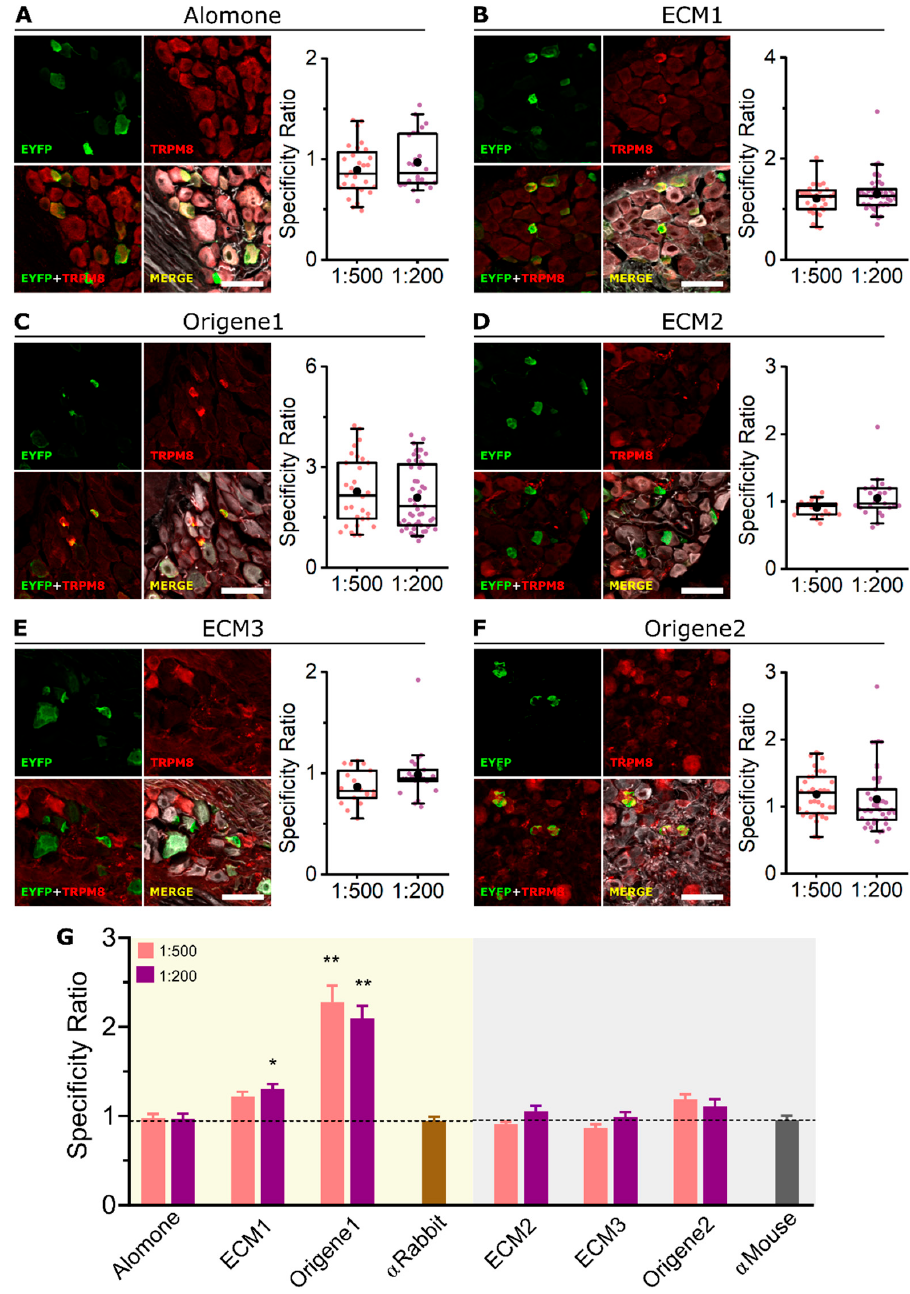
Figure 6. Immunohistochemistry of endogenous TRPM8 in DRG slices from the Trpm8 BAC -EYFP + mouse. ( A – F left) Confocal images of TRPM8+ sensory neurons. EYFP (green), TRPM8 antibody (red) and β III-Tubulin (grey). Scale bar: 50 µm. ( A – F right) Box plots represent specificity ratio (SR) for each dilution of the respective antibody. Each dot corresponds to an individual EYFP+ cell. Box contains the 25th to 75th percentiles. Whiskers mark the 5th and 95th percentiles. The line inside the box denotes the median and the black dot represents the mean. (Differences among dilutions were not significant, Mann–Whitney test). ( G ) Bar histogram summarizing the SR mean ± SEM of each TRPM8 antibody and the controls without primary antibody ( α Rabbit or α Mouse secondary antibodies alone). Dashed line indicates SR = 1. (* p < 0.05, ** p < 0.01, Kruskal–Wallis followed by Dunn´s post hoc test vs. α Rabbit or α Mouse). n = at least 18 cells; 4 images from 2 mice for each antibody and dilution.